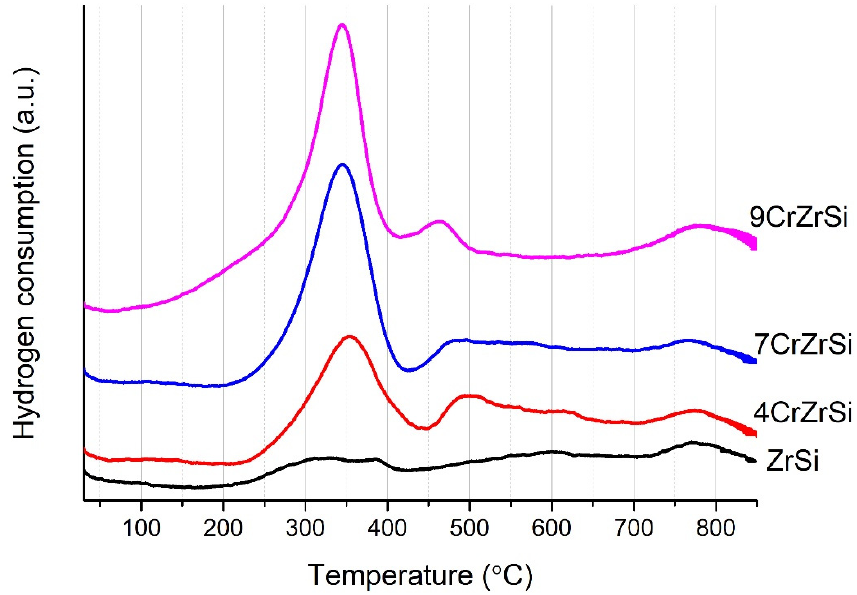
Figure 3. TPR-H 2 profiles of fresh ZrSi and CrZrSi catalysts.